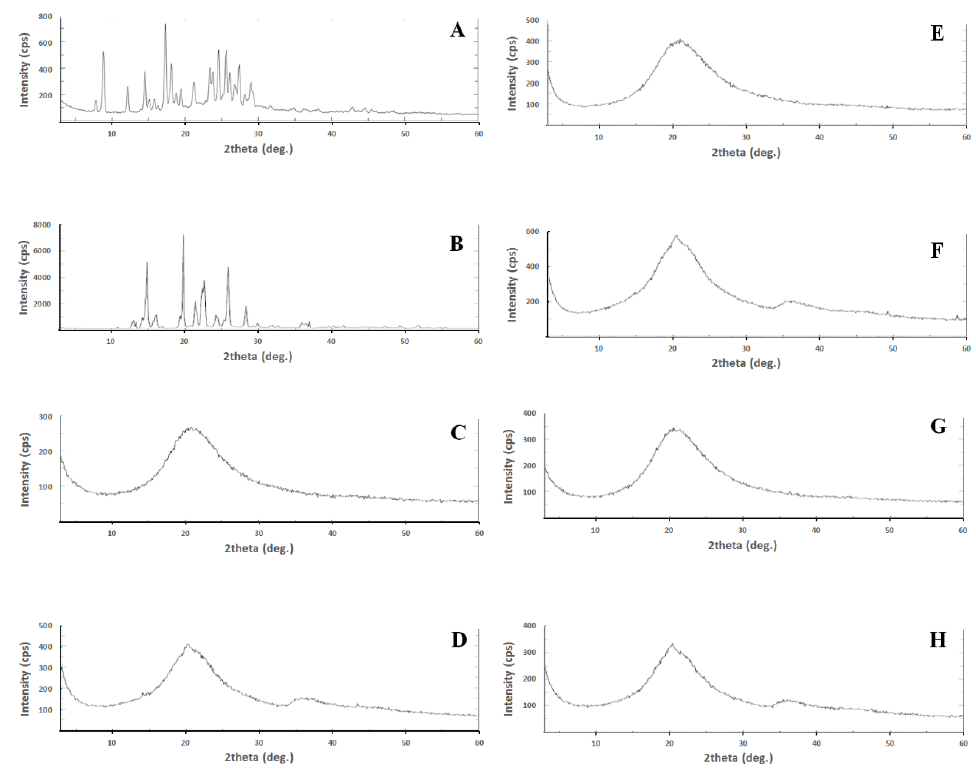
Figure 8. XRD of ( A ) pure CUR, ( B ) pure PP, ( C ) F1A, ( D ) F1N, ( E ) F2A, ( F ) F2N, ( G ) F6A and ( H )